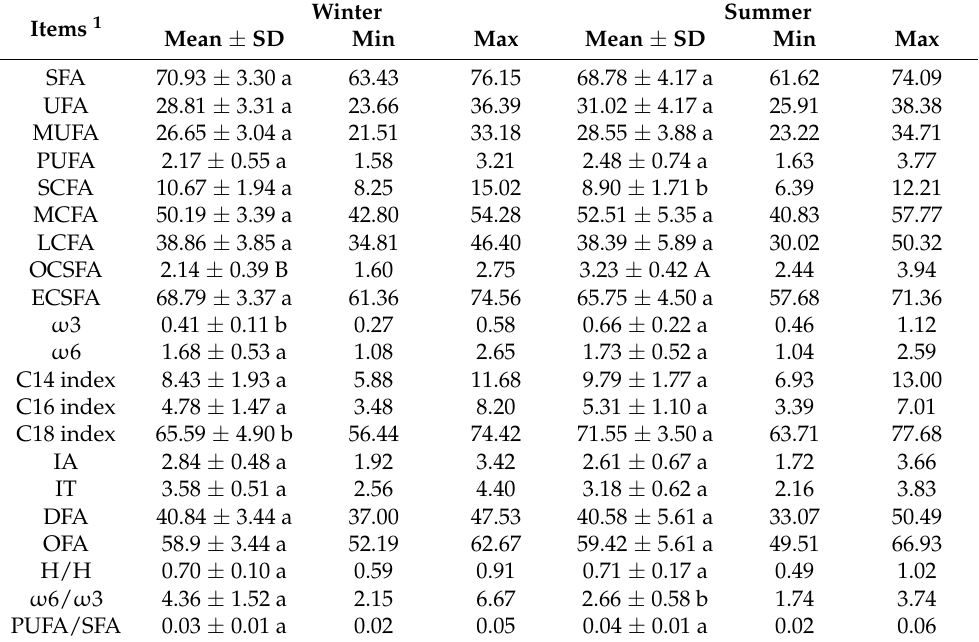
Table 4. Mean (g/100 g of fatty acids) ± SD and range of fatty acids groups and lipid quality health indices of crossbred buffalo raw milk in winter and